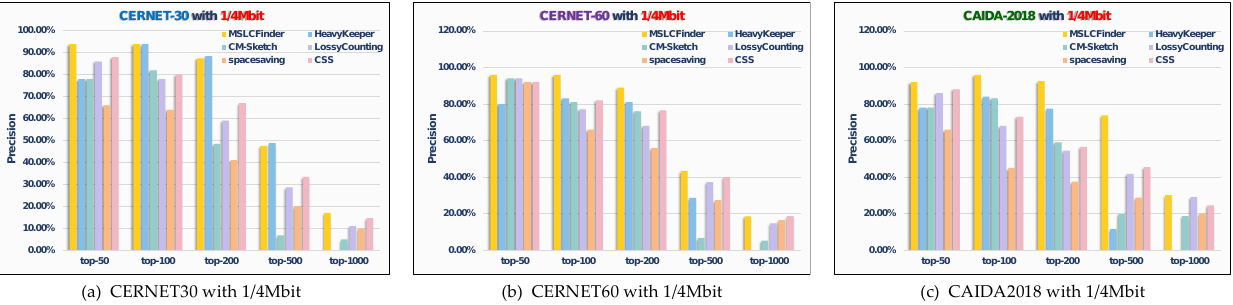
Figure 12. Experiments on precision vs. six methods of three datasets with 1/4 Mbit. ( a ) CERNET-30 with 1/4 Mbit. ( b ) CERNET-60 with 1/4 Mbit. ( c ) CAIDA-2018 with 1/4